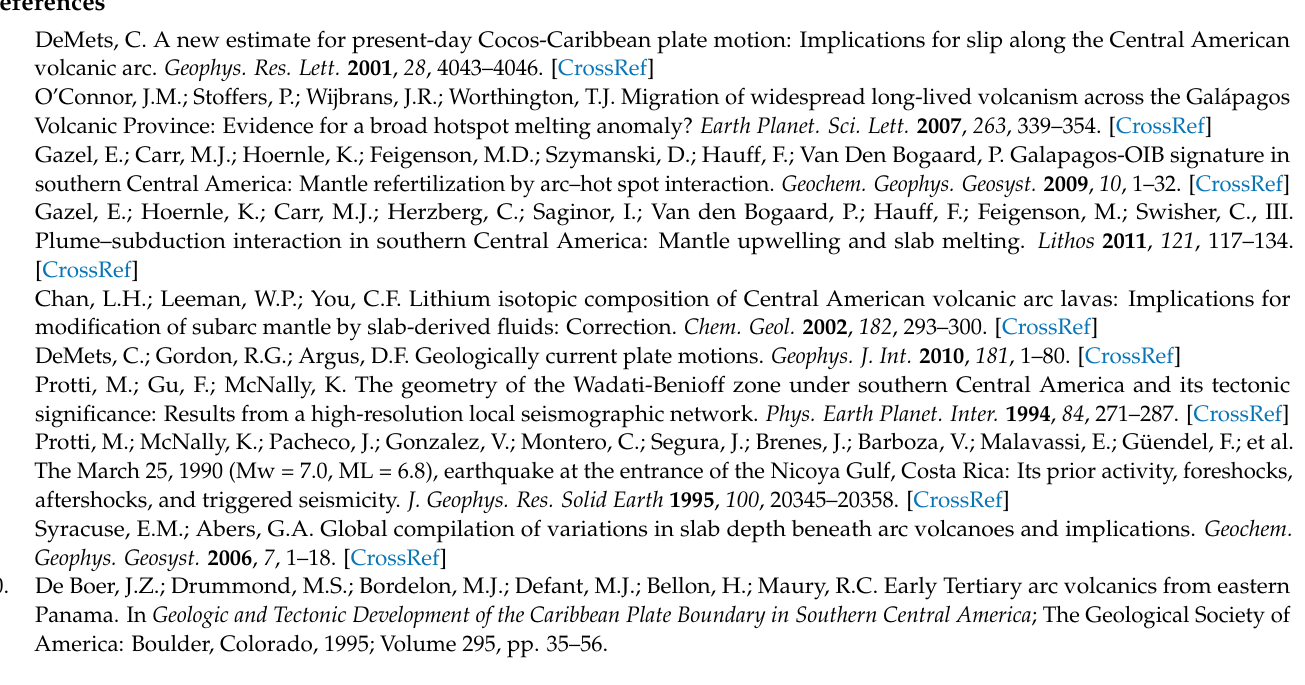
10.3390/app12094241/s1, Figure S1: Mineral Chemistry—Diagram, Figure S2: Plots of Geomarker ratios vs. distance (km) along the arc from the border between NW and SE CAVA, Figure S2: Binary plots of Geomarker ratios, Figure S3: The trace and rare earth element data ratios are plotted in binary diagrams. Table S1: Bulk rock data composition, Table S2: Mineral chemistry, Table S3: Isotopic noble gas data from gases in CAVA literature, Table S4: Isotopic noble gas data from FIs in CAVA